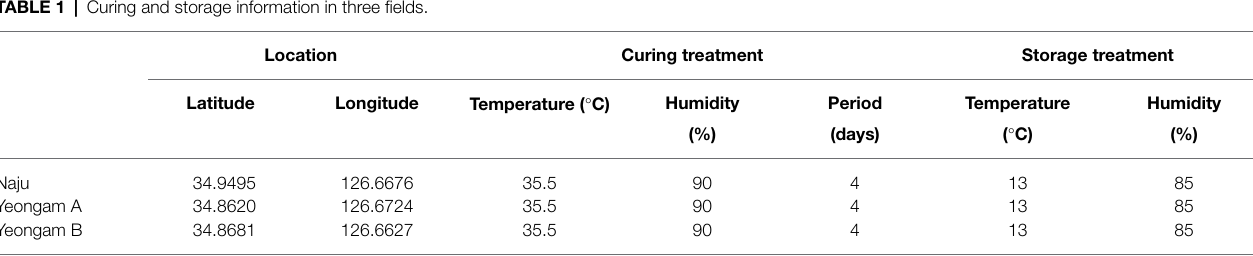
TABLE 1 | Curing and storage information in three